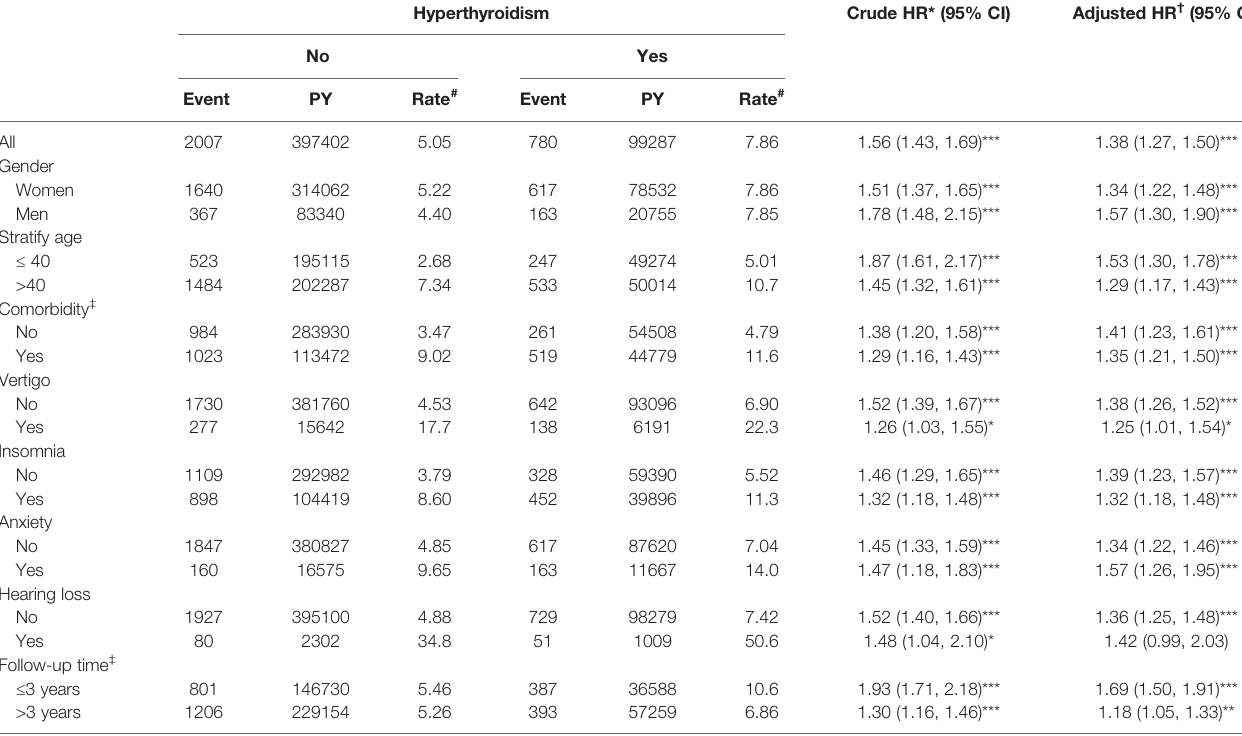
PY, person-years. Rate # , incidence rate, per 1000 person-years; Crude HR*, relative hazard ratio; Adjusted HR † : multivariable analysis including age, gender, urbanization level and comorbidities of vertigo, insomnia, anxiety, and hearing loss; *p < 0.05, **p < 0.01, ***p < 0.001. Comorbidities ‡ : Patients with any one of the comorbidities vertigo, insomnia, anxiety, and hearing loss were classi fi ed as the comorbidity group. ‡ The follow-up time is partitioned into 2 segments (years ≤ 3, and >3 years) by fi rst